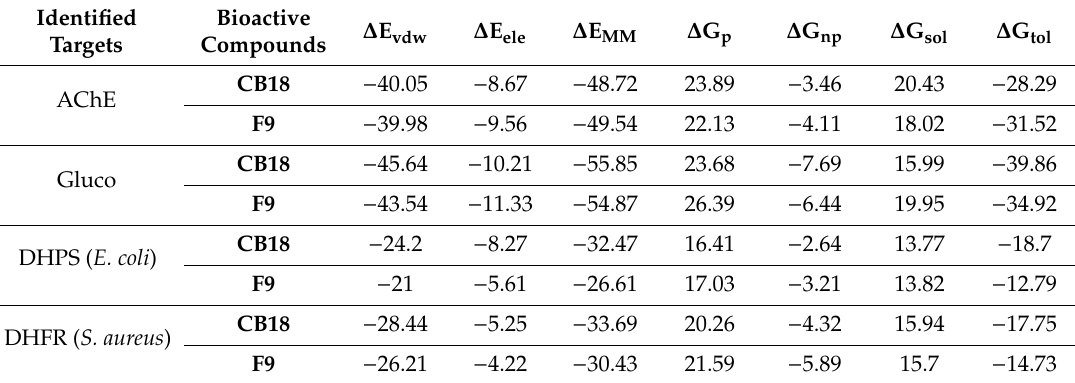
Table 6. Binding a ffi nities and contributing energies of the